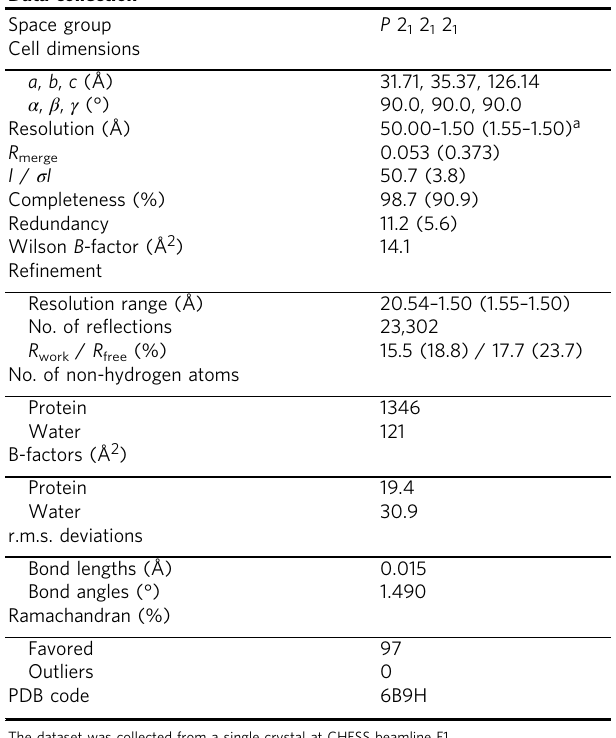
Table 1 Data collection and re fi nement